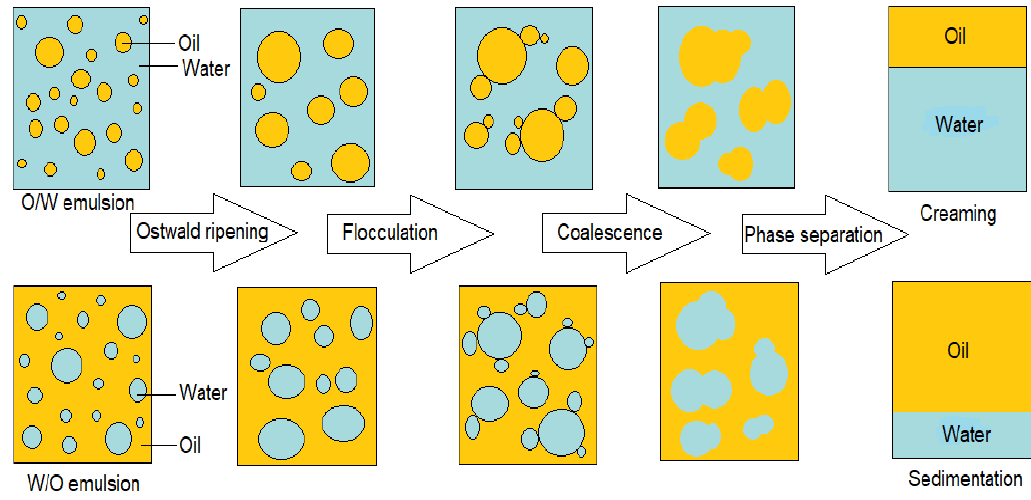
Figure 3. Schematic of chemical demulsification mechanism [31].